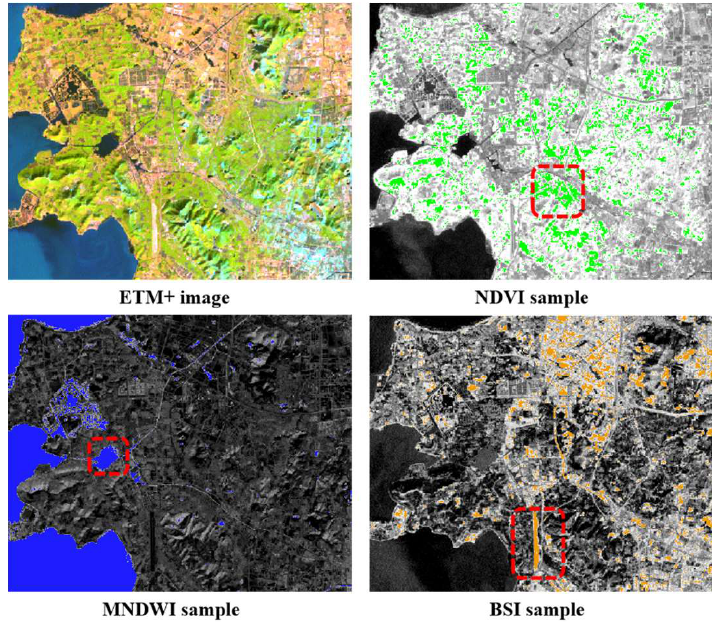
Figure 4. Selected samples in Landsat 7 ETM + images, histogram of the normalized di ff erence vegetation index (NDVI) ( a ) and the range of extreme values in Suzhou ( b ).